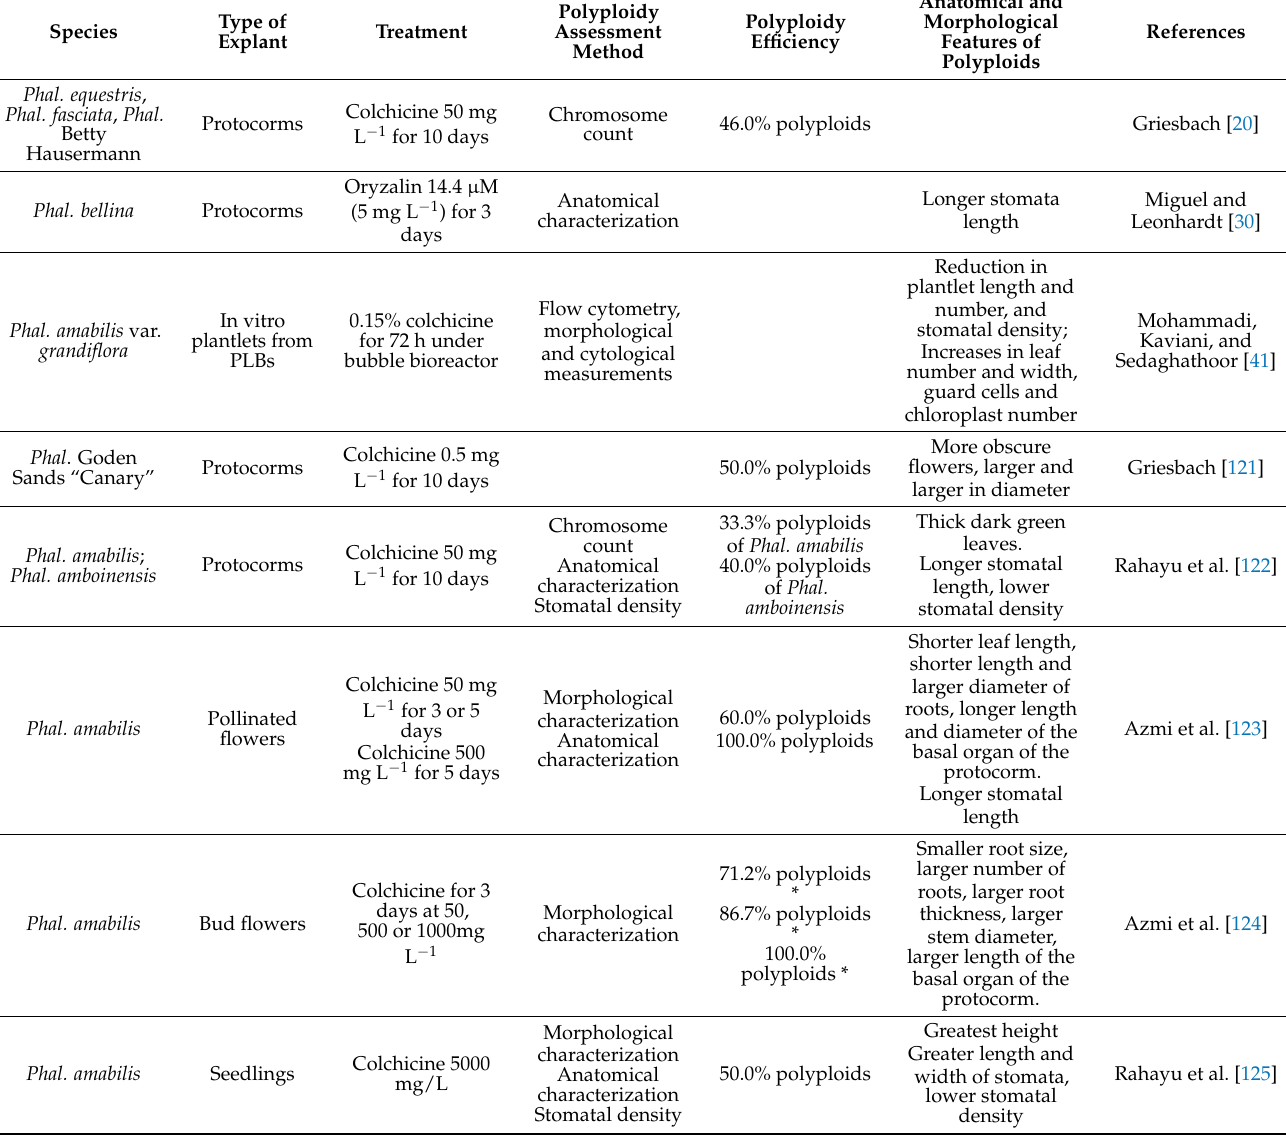
Table 5. Polyploidy induction of Phalaenopsis